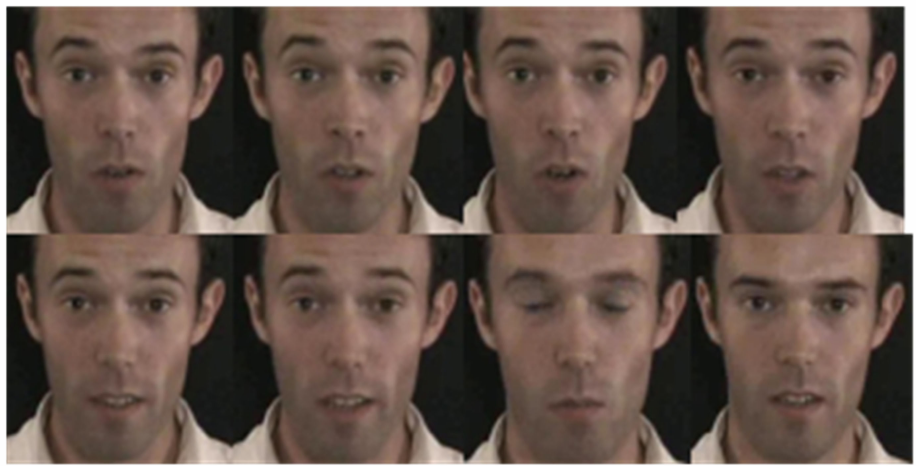
Figure 6. Example of eNTERFACE’05. Subjects perform emotions in preset scenes and read pre- set